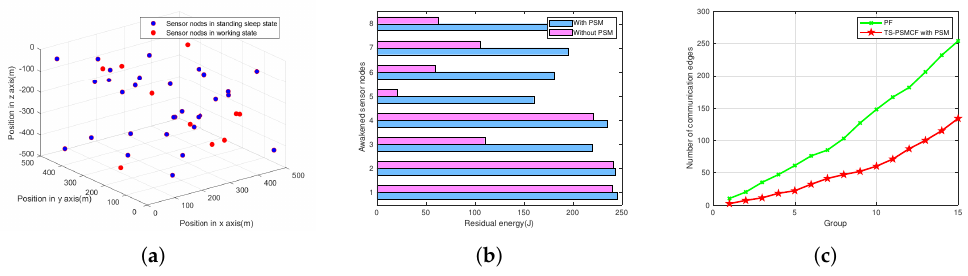
Figure 14. Simulation of TS-PSMCF with PSM (energy consumption). ( a ) Location and status of sensor nodes. ( b ) Residual energy of network. ( c ) The number of communication edges.